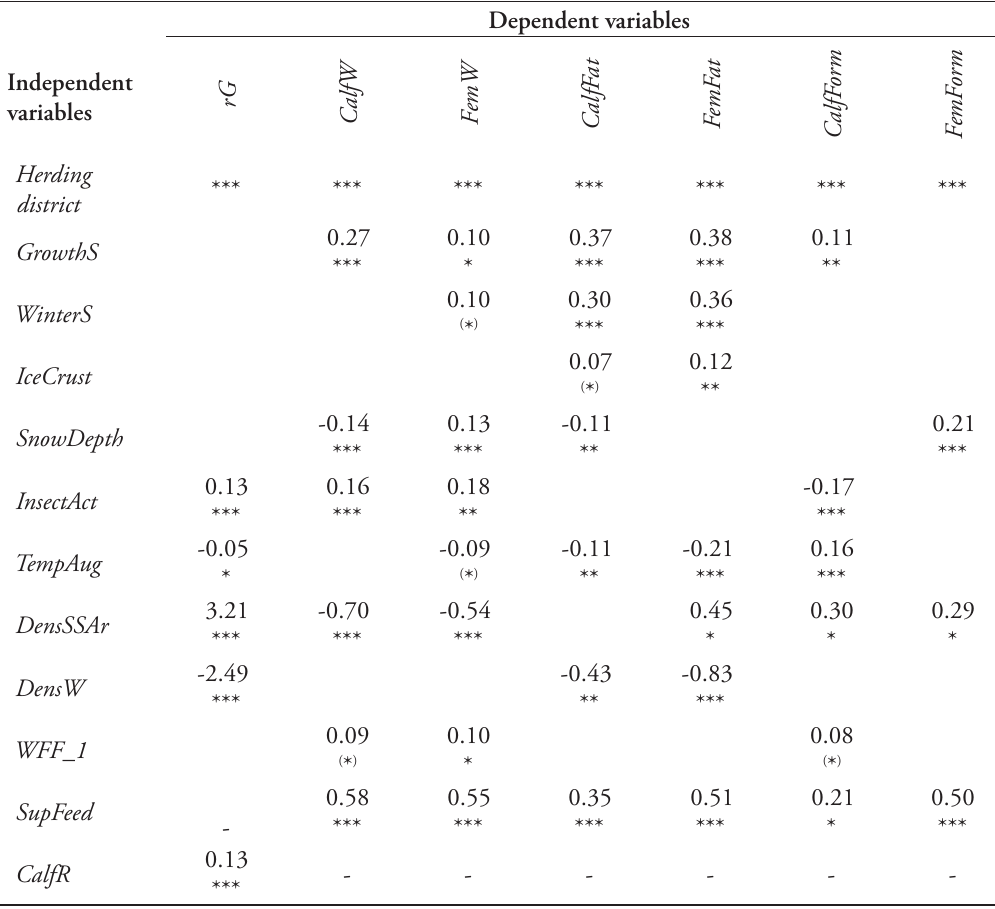
Table 3. Estimated regression coefficients of productivity variables on temporally varying explanatory variables, obtained in stepwise linear model analyses with Herding district included as class variable. Insig- nificant coefficients are not shown, and CalfR was included in the rG analyses